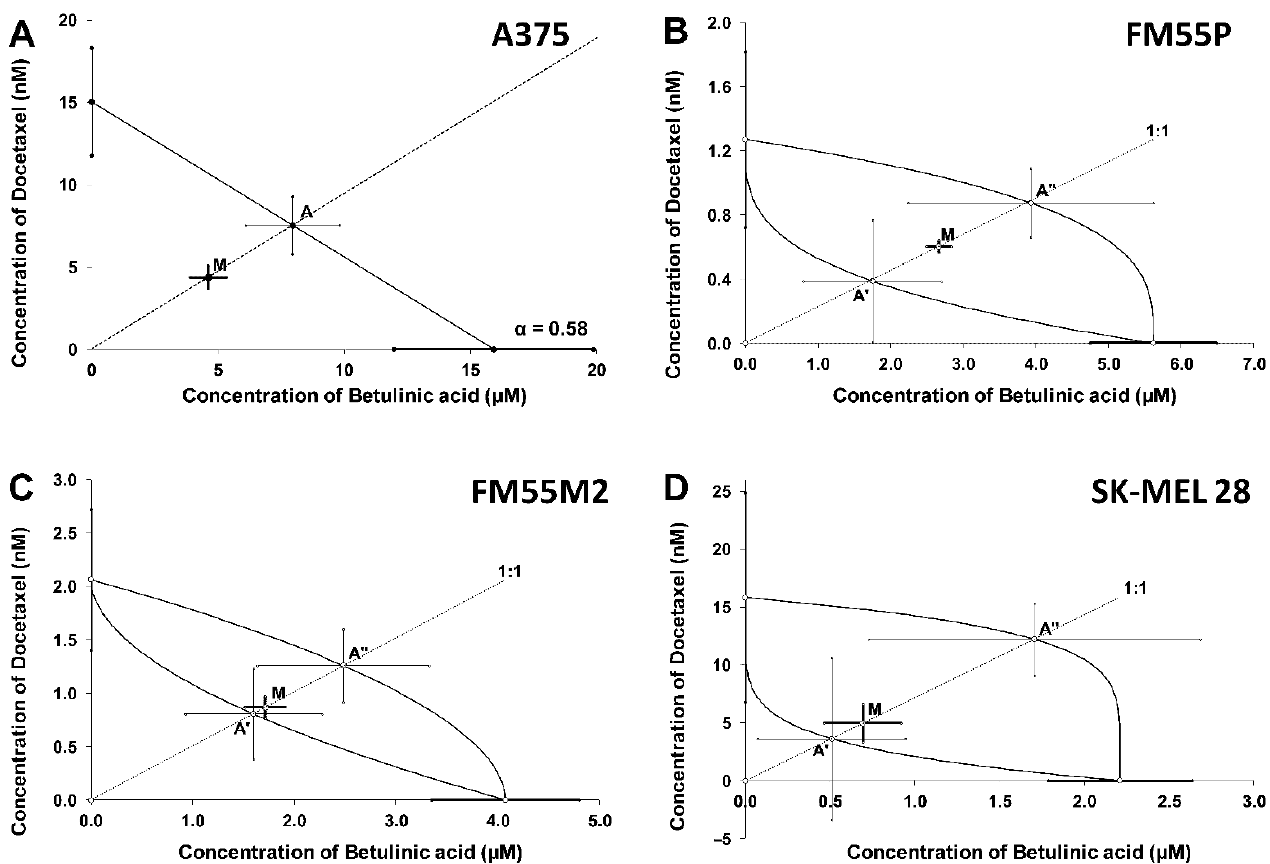
Figure 9. ( A – D ). Isobolograms showing interactions between betulinic acid (BA) and docetaxel with respect to their anti-proliferative effects on A375 ( A ), FM55P ( B ), FM55M2 ( C ), and SK-MEL28 ( D ) malignant melanoma cell lines measured in vitro by the MTT assay. The median inhibitory concentrations (IC 50 ) for BA and docetaxel are plotted graphically on the X- and Y-axes, respectively. For more details see Figure 6.